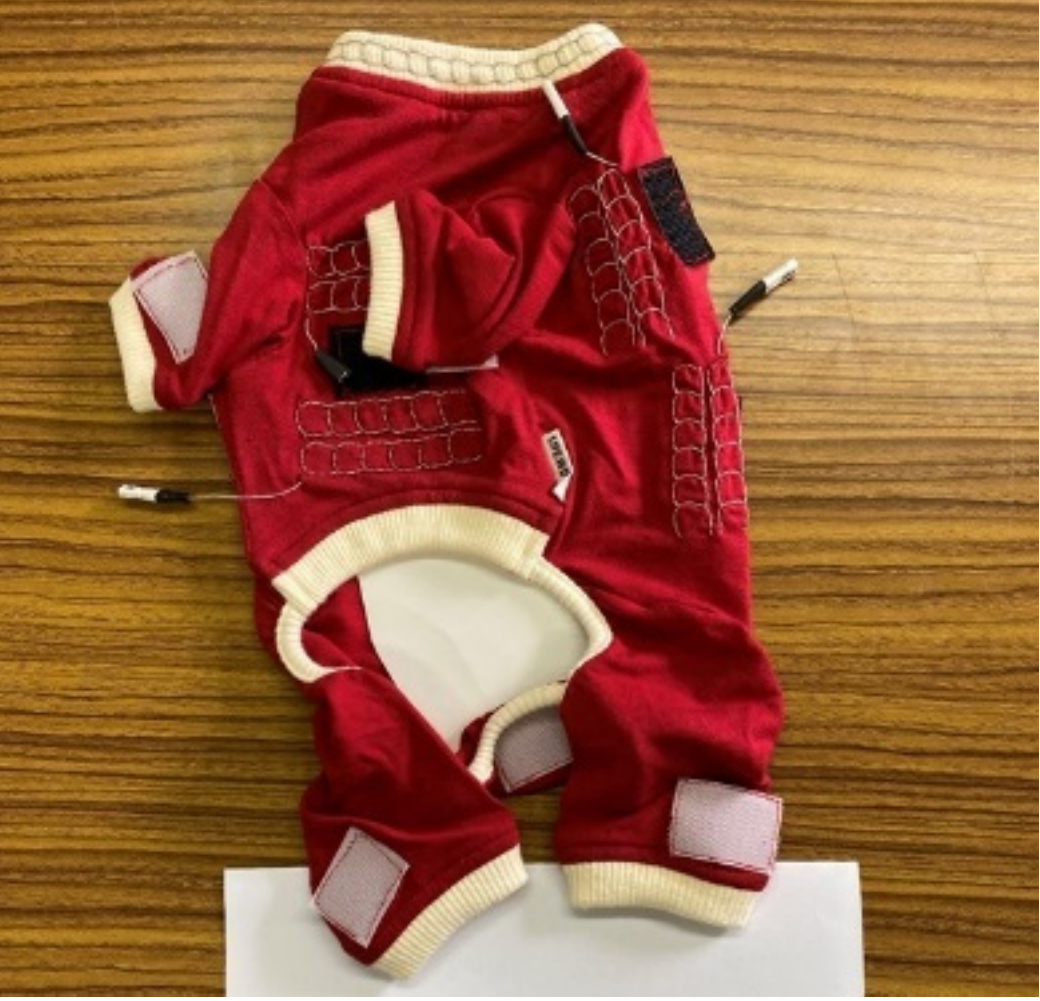
Figure 9. Dog wear for toy poodles embroidered with piezoelectric PLLA braided cords using chain stitch.